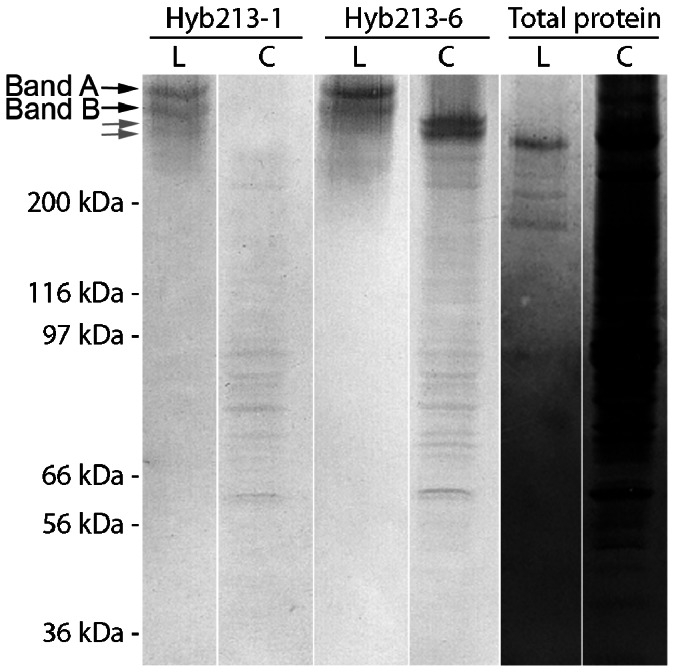
SDS-PAGE and Western blot of lung washing (L) and colon tissue (C) in the non-reduced state.The blots were incubated with the two monoclonal antibodies Hyb213-1, Hyb213-6 or stained for total protein content as described in the Materials and Methods section. Black arrows: Double band (band A and B) of DMBT1gp340 from bronchoalveolar lavage. Grey arrows: Double band of DMBT1 from colon tissue.